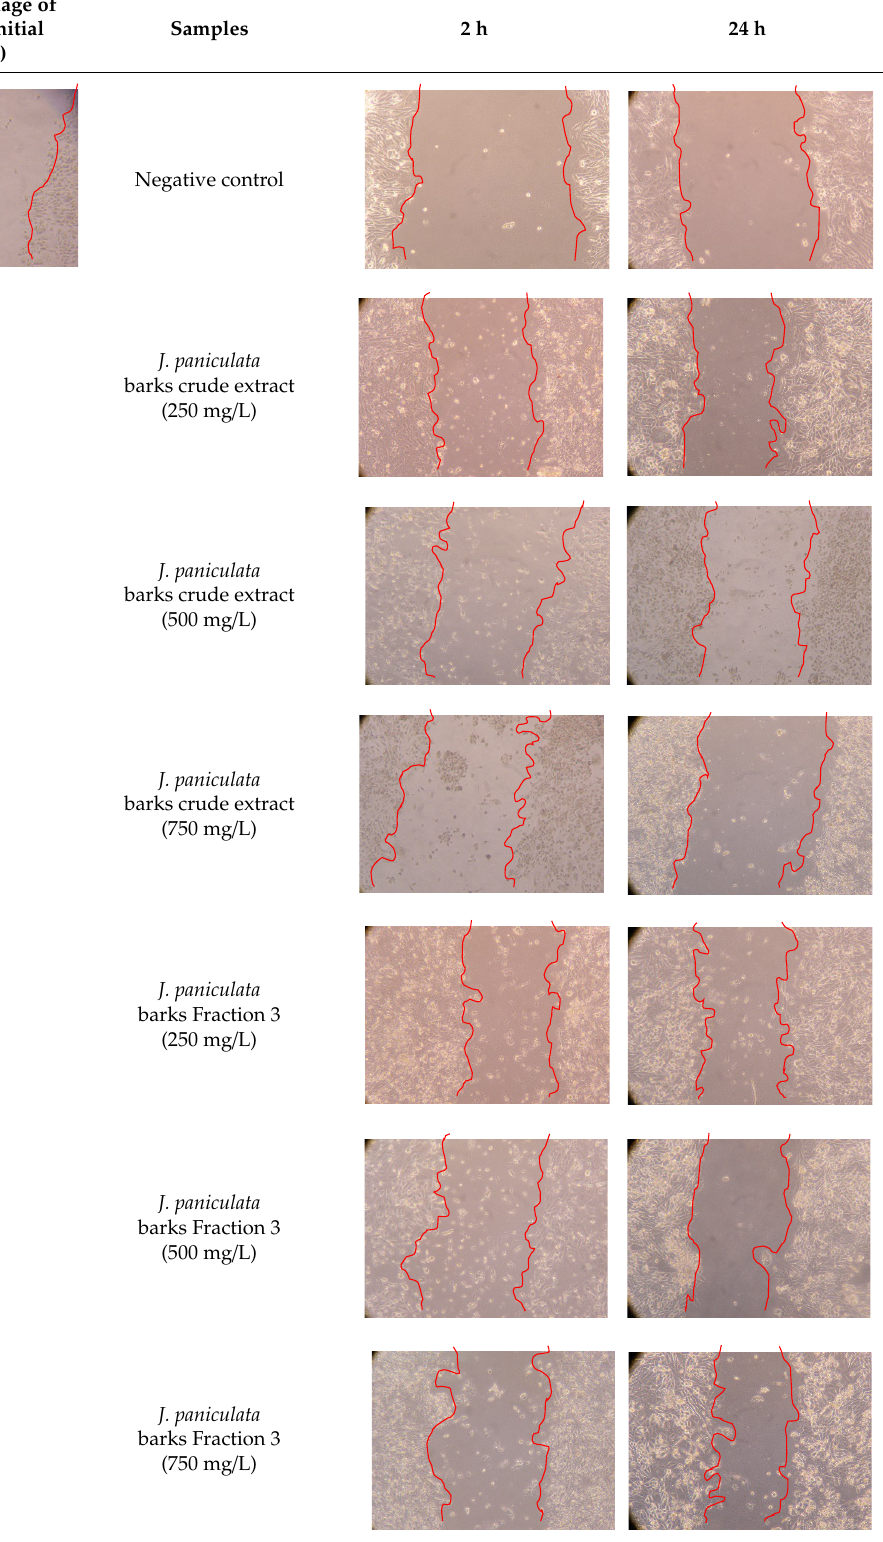
Table 9. Microscopic images obtained from the scratch wound-healing assay with the selected samples of J. paniculata (Magnification: 100 × ).